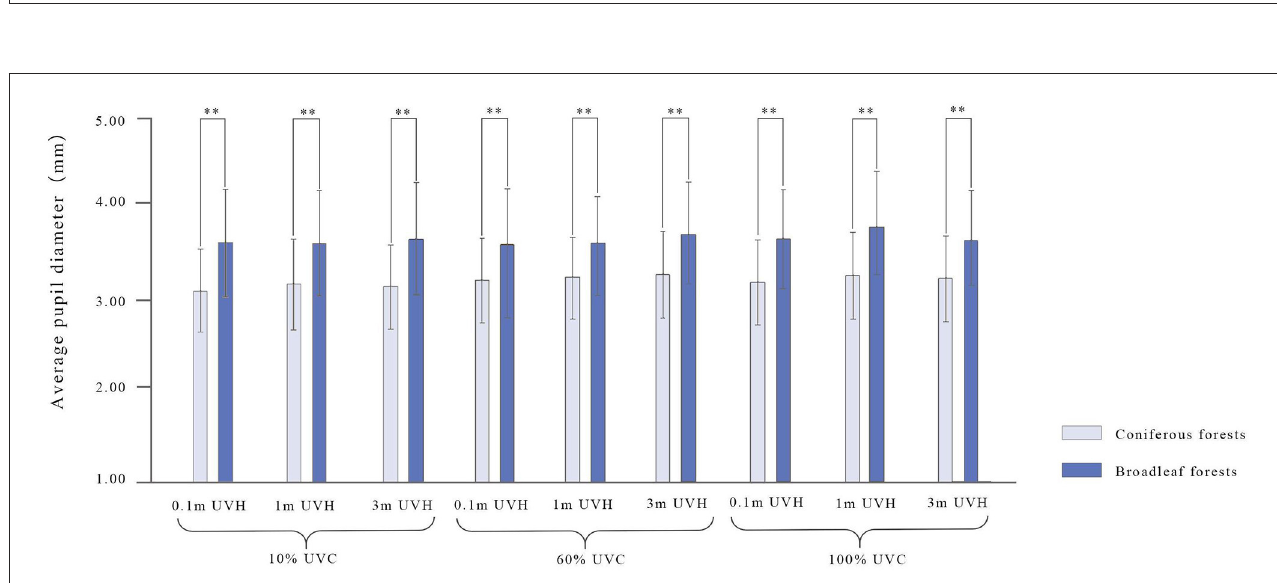
FIGURE9 The interaction difference of UVC and UVH on average pupil diameter in two forest types. UVC, understory vegetation cover; UVH, understory vegetation height. ** p < 0.01.